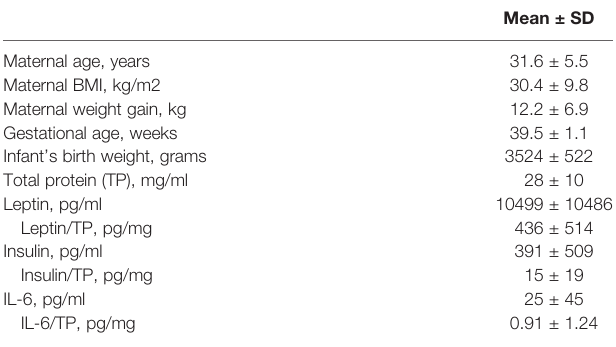
TABLE 1 | Patient characteristics and hormone levels in cord blood